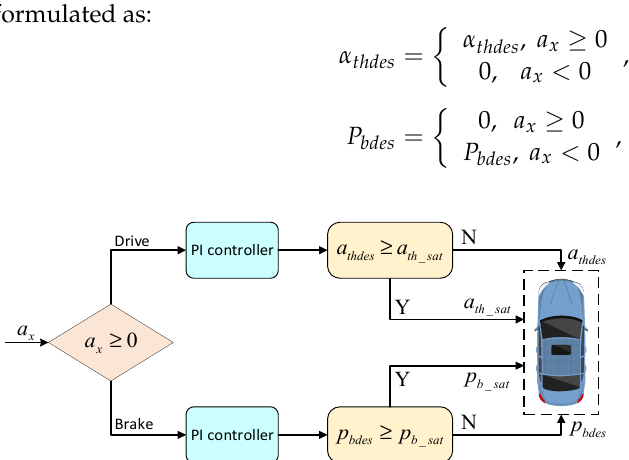
Figure 7. Lower-level controller implementation block diagram.